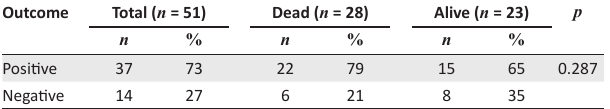
TABLE 4: Outcome by human immunodeficiency virus (HIV) status in treatment group. Outcome